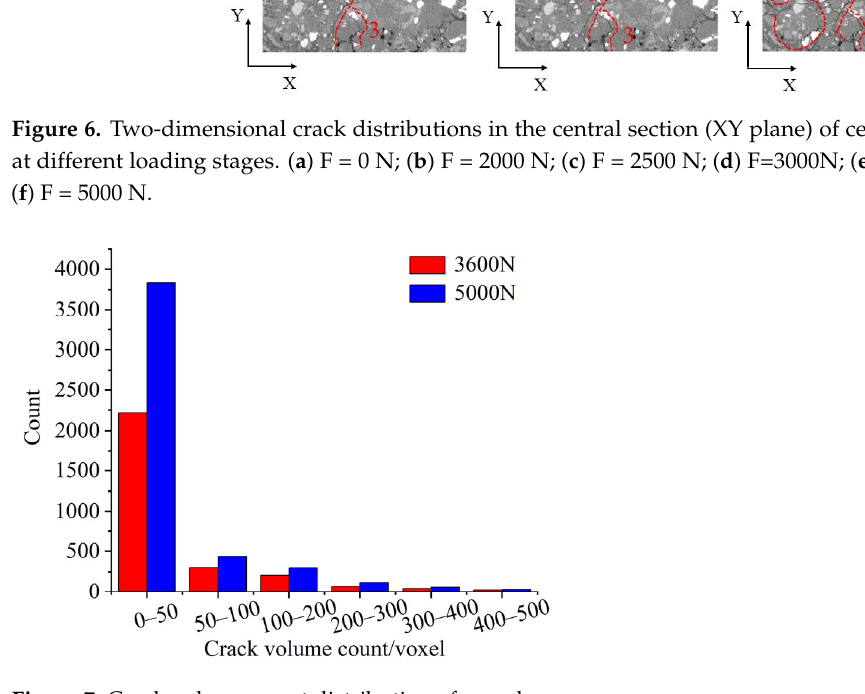
Figure 7. Crack volume count distribution of sample.